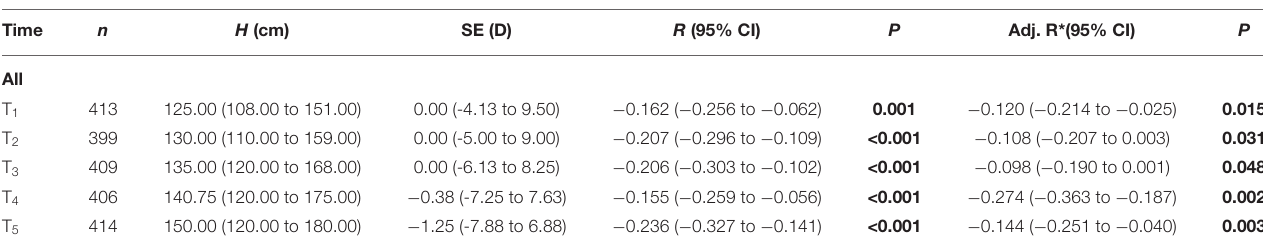
TABLE 4 | Correlation between height and refraction in all